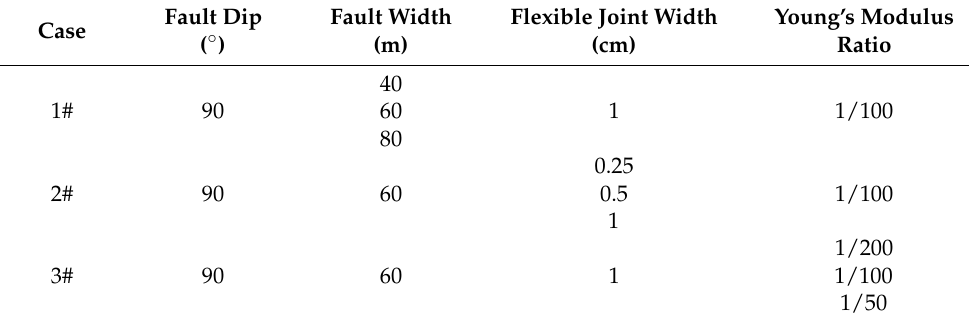
Table 7. Calculation